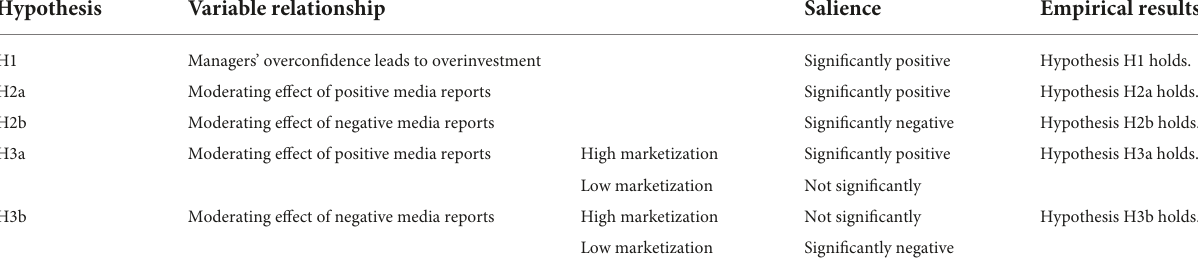
TABLE 8 Summary of variable regression